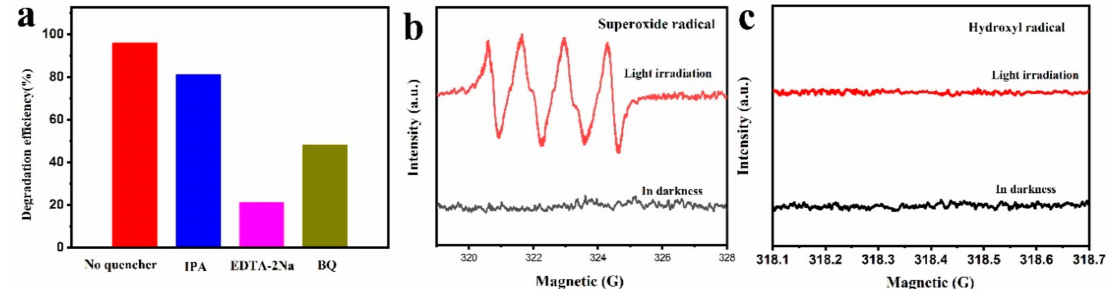
Figure 9. ( a ) Trapping experiments of active species during photodegradation of CIP in the presence of kaolin / CeO 2 / g-C 3 N 4 under visible light irradiation; ( b ) DMPO − • OH and ( c ) DMPO − • O 2 − adducts on kaolin / CeO 2 / g-C 3 N 4 under visible light irradiation.